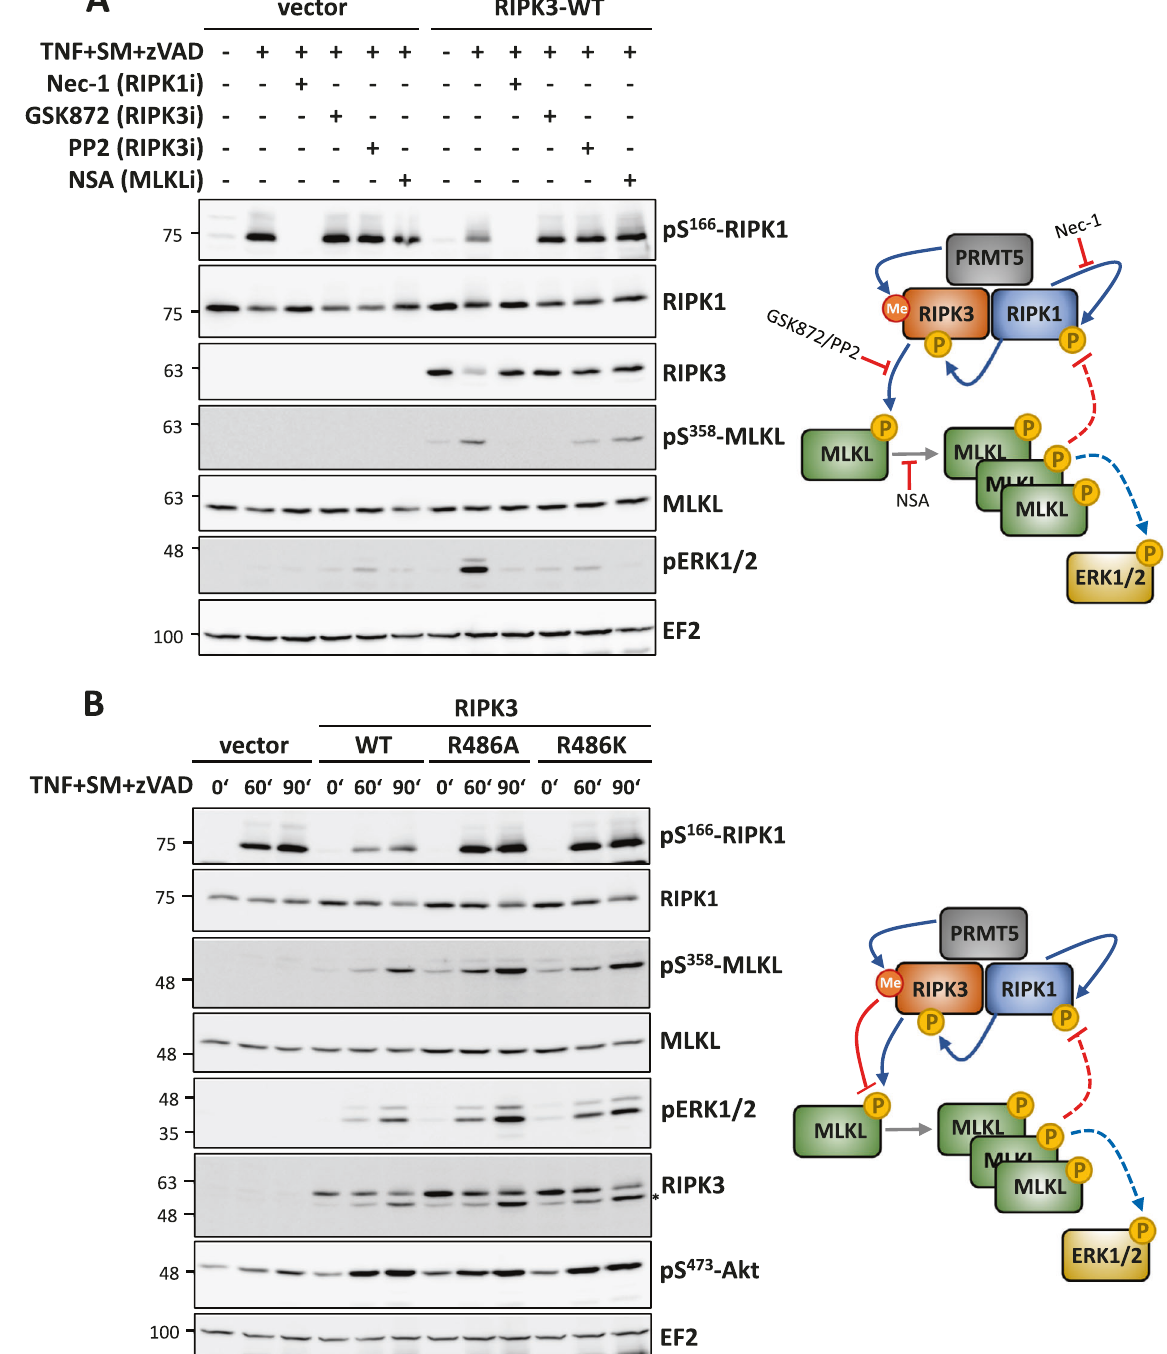
Fig. 4 RIPK3-mediated feedback control on RIPK1 activity is dependent on RIPK3 methylation. A The necroptosis-incompetent PANC1 cell line, which lacks RIPK3, was rescued by lentiviral transduction of FLAG-tagged WT-RIPK3 or empty vector. Necroptotic signaling was monitored by stimulating cells with TNF α , Smac-mimetics (SM) and zVAD-fmk for 90 min in the absence or presence of indicated kinase inhibitors (Nec-1, GSK'872) or PP2 (RIPK3 oligomerisation inhibitor) or necrosulfonamide (NSA), an inhibitor of human MLKL oligomerisation (inhibitor pre- treatment for 30 minutes before TNF stimulation). The right panel shows the schematic summary of the observations. RIPK3 expression facilitates necroptotic signaling in PANC1 cells (MLKL and ERK1/2 phosphorylation) but suppresses RIPK1 autophosphorylation (RIPK1-S166). The feedback control of RIPK3 on RIPK1 was abrogated by RIPK3 and MLKL inhibitors. B PANC1 rescue model as in A comparing the necroptotic signaling in cells transduced with WT and methylation site mutants (R486K and R486A) of FLAG-tagged RIPK3 (*indicates remnants of pMLKL bands when reprobed with RIPK3). The corresponding panel to the right summarizes the conclusions from the immunoblots. Top right panel depicts the signaling effects and the processes targeted by the inhibitors used. RIPK3 activation by RIPK1 leads to MLKL phosphorylation and oligomerisation, with downstream ERK1/2 signaling. The oligomerisation of MLKL also seems necessary for suppressing pS166-RIPK1 phosphorylation. The lower panel scheme depicts the possible effect of RIPK3 methylation in the same system. RIPK3-mediated suppression of RIPK1-S166 is lost upon methylation site mutation. In addition, the necroptotic signaling is also enhanced in the absence of R486 methylation. This indicates an inhibitory role for RIPK3-methylation in RIPK3 downstream signaling including the feedback control of RIPK1 activity. Cell Death Discovery (2023)